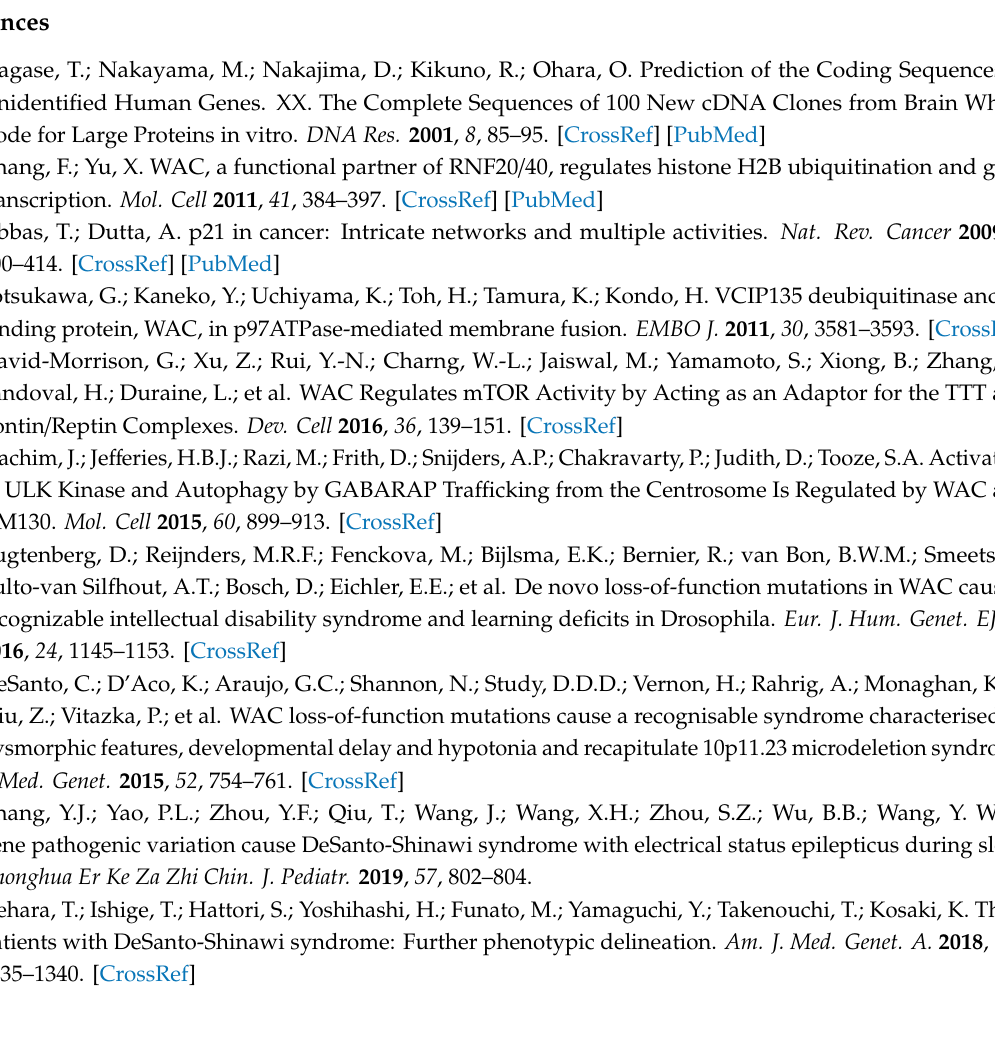
Table S1: Psychometric test scores for Patient 3, Table S2: WAC mutation